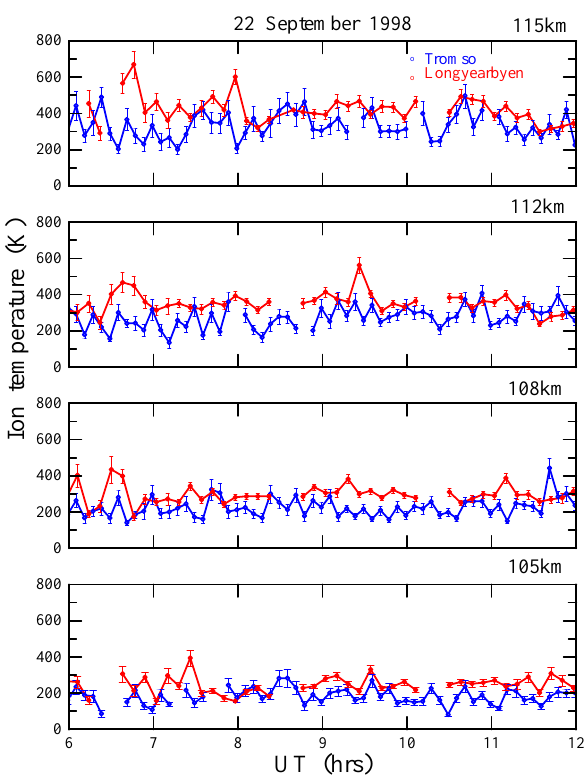
Fig. 6. Ion temperature parallel to the geomagnetic field between 105 and 115km at Tromsø (blue) and Longyearbyen (red) from 06:00 to 12:00UT on 22 September 1998. Error bars depict the rms random noise